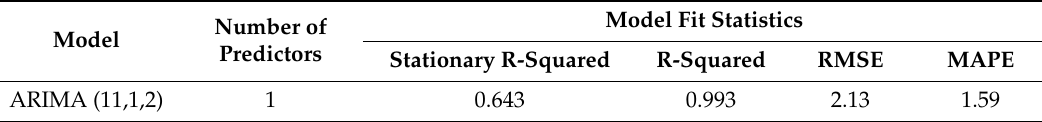
Table 6. Parameters of the goodness of fit for the ARIMA (11,1,2) Model.